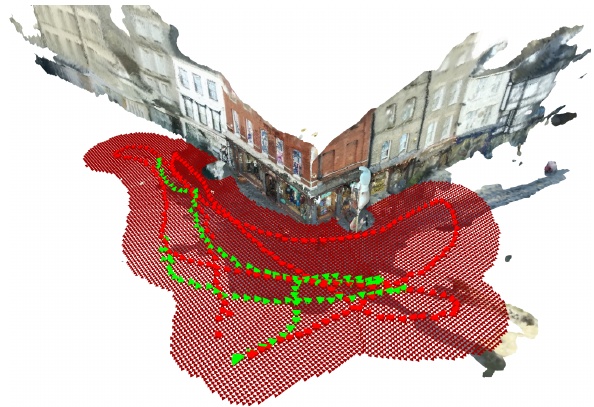
Figure 3. Visualization of synthetic generated poses for the ren- dered respectively translated images (dark red), poses of of the captured training images (red) and poses of the captured test images (green).